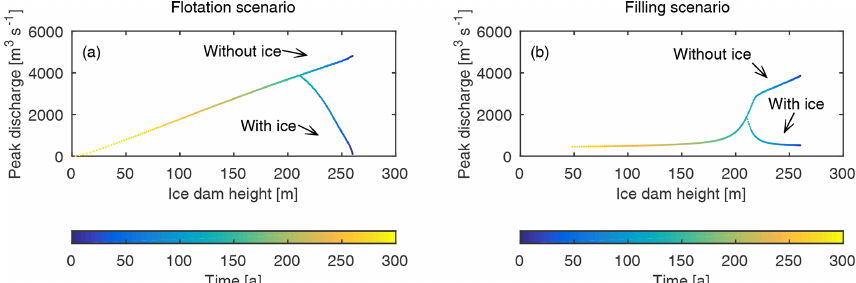
Figure 9. Comparison of peak discharge and ice dam height for the box-shaped basin under the (a) flotation scenario and (b) filling scenarios. “With ice” indicates the relationship between peak discharge and ice dam height when remnant ice is accounted for in the model, whereas “Without ice” indicates the relationship when remnant ice is